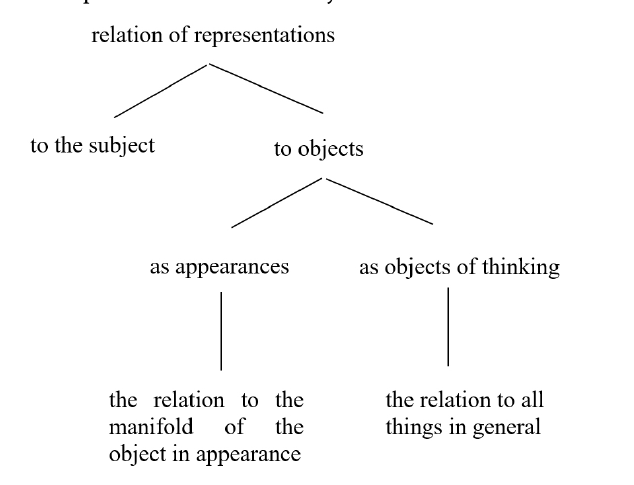
Figure 1. [ Michael